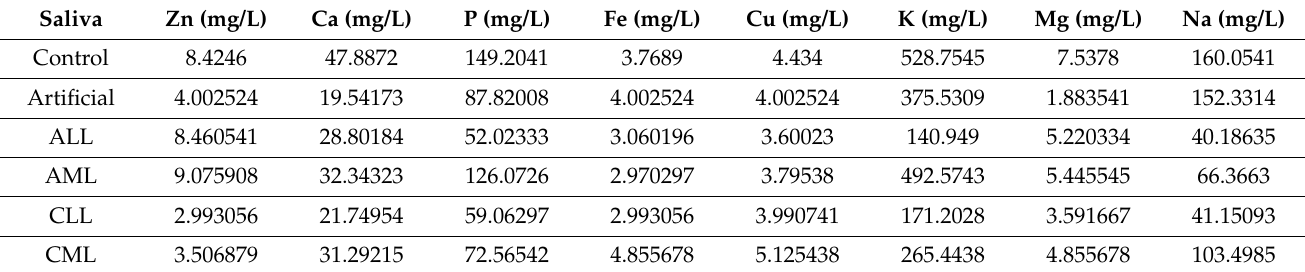
Table 4. Concentrations of major elements in whole